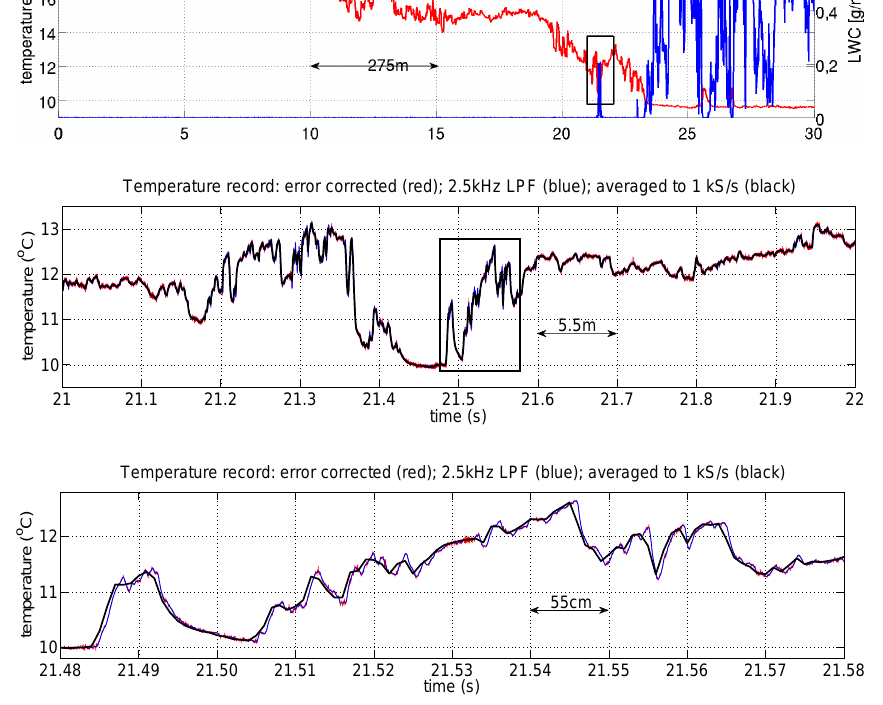
Fig. 10. The uppermost panel presents temperature fluctuations (red) recorded during the descent into the stratocumulus cloud. The smooth signal at 0–9s is identified as recorded inside the free troposphere; that at 9–21.2s as the temperature fluctuations in the inversion capping the cloud deck (no significant LWC, blue); and that at 21.2–30s as the temperature fluctuations at the cloud top and inside the cloud. The two lower panels present consecutive blow-ups of temperature records to illustrate sensor performance. Colour code on these panels correspond to that in Fig.